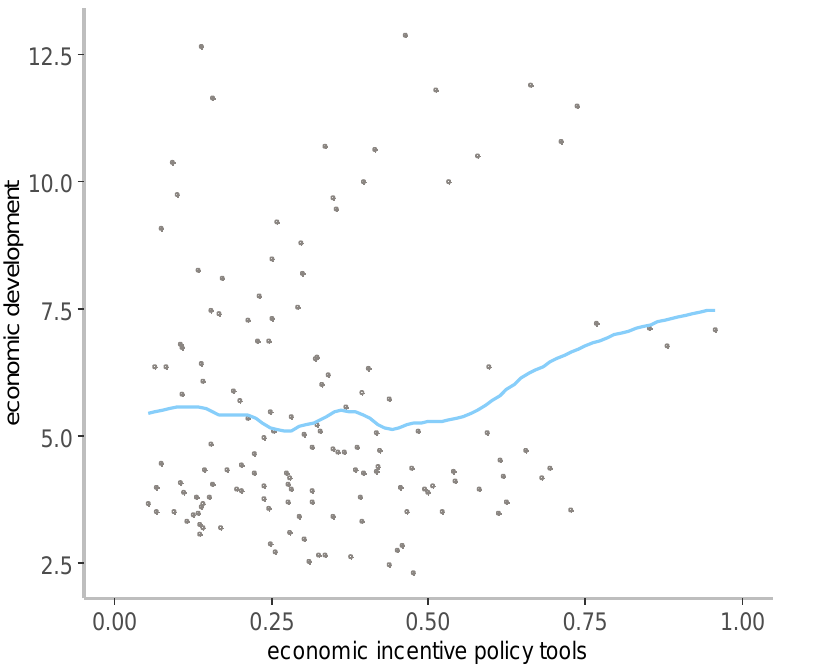
Figure 3. Scatterplot between economic incentive policy tools and economic